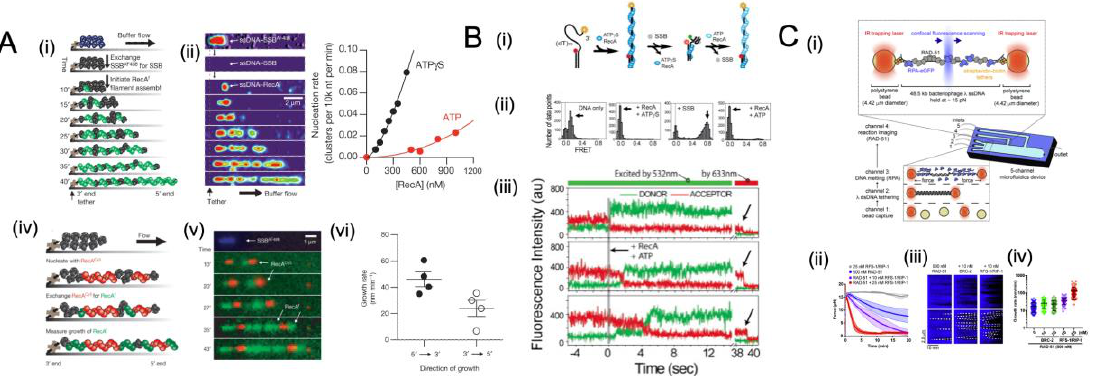
Figure 7. Examples of single-molecule studies of SSB interplay with recombinase. (A) Direct obser- vation of RecA filament assembly on single-stranded DNA (ssDNA) coated with SSB demonstrates that RecA nucleates as a dimer and grows in a bidirectional manner. Visualization was done using TIRF microscopy in a microfluidic flow chamber. Results showed that higher RecA concentrations lead to increased nucleation rates and that the growth occurs faster from the 5' end in the 5 ′ → 3 ′ direction with a rate of 44 ± 11 nm min −1 . Images adapted from Figures 1 and 3 of [39]. (B) The displacement of SSB by RecA in the presence of a preformed nucleation cluster was shown using smFRET traces. Results indicate that RecA efficiently displaces SSB by quickly forming a filament. Reprinted from Cell, Volume 126, Issue 3, Chirlmin Joo, Sean A. McKinney, Muneaki Nakamura, Ivan Rasnik, Sua Myong, and Taekjip Ha. “Real -Time Observation of RecA Filament Dynamics with Single Monomer Resolution”. Pages 515– 27. 2006, with permission from Elsevier [204]. (C) The as- sembly and growth of RAD-51 filaments on RPA-coated ssDNA were studied using optical twee- zers and confocal fluorescence microscopy in vitro using fluorescently labelled C. elegans proteins. The RPA-eGFP fusion protein was coated on a force-melted ssDNA [49]. In the presence of ATP, the traps were moved to protein channels containing RAD-51 or mediator proteins to initiate the assem- bly of RAD-51. The assembly of the RAD-51 and displacement of the RPA-eGFP were followed by the loss of fluorescence of eGFP and the simultaneous decrease in the force exerted on the ssDNA associated with recombinase filament formation [216]. (ii) Forces are measured between the traps as a function of time in different RFS-1/RIP-1 concentrations; shaded areas represent SEM (n = 3 to 8